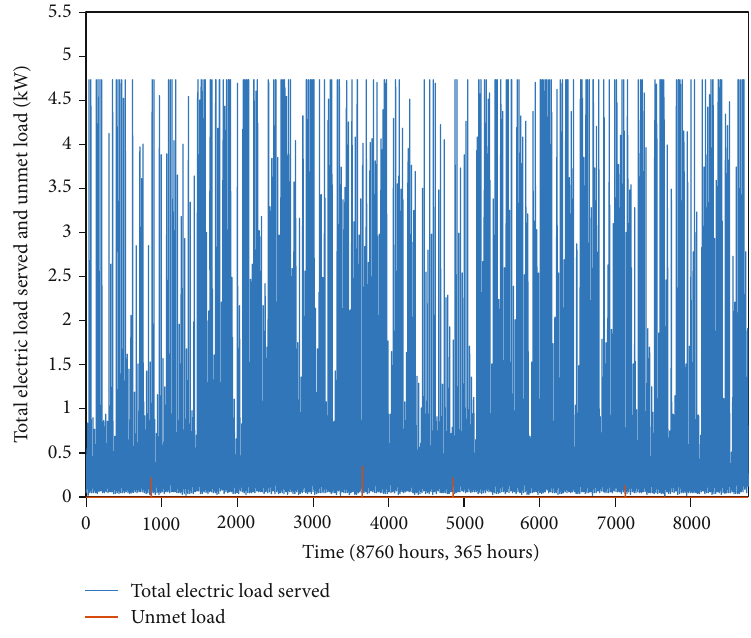
Figure 24: Total electric load served and unmet electric load for the unreliable grid model with the PV system as the